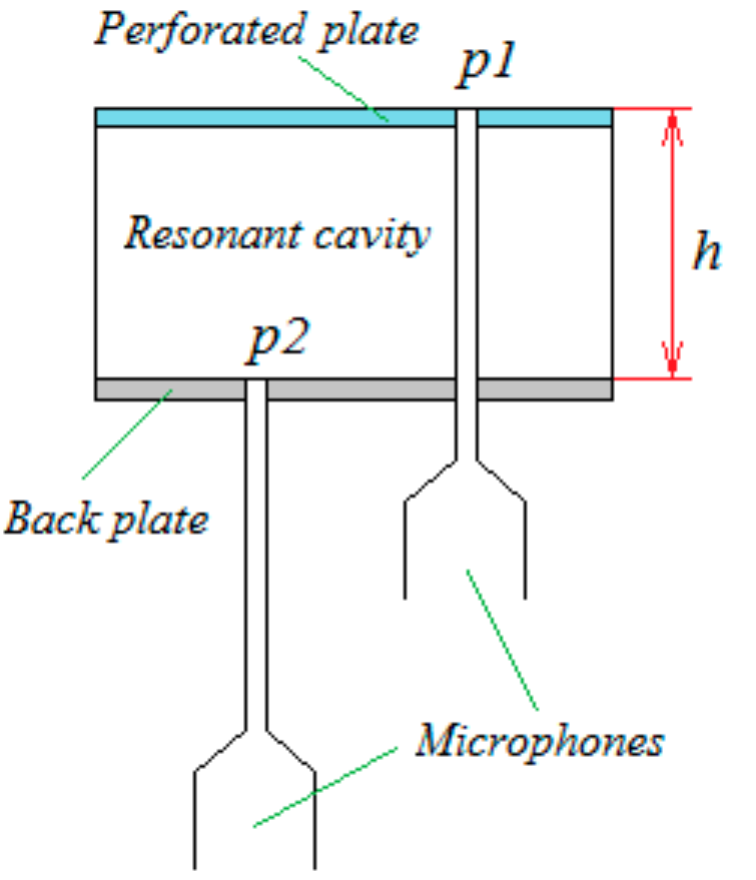
Figure 2. Installation of microphones into the resonator cell for determination of the impedance by Dean’s method.